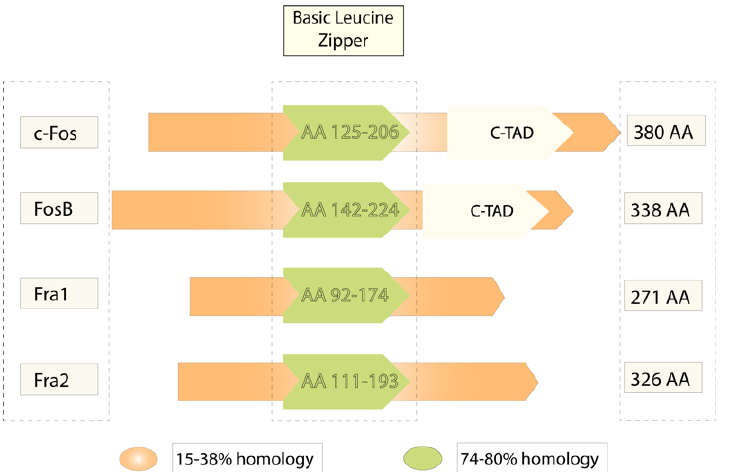
Figure 1. The Fos gene family members. The picture shows a comparative structure of the products of the fos gene, all of which contain a basic leucine zipper domain, but only c-fos and FosB have a c-terminal transactivator domain (c-TAD). It also indicates the high homology level in the basic leucine zipper domain, which is more variable in other regions.